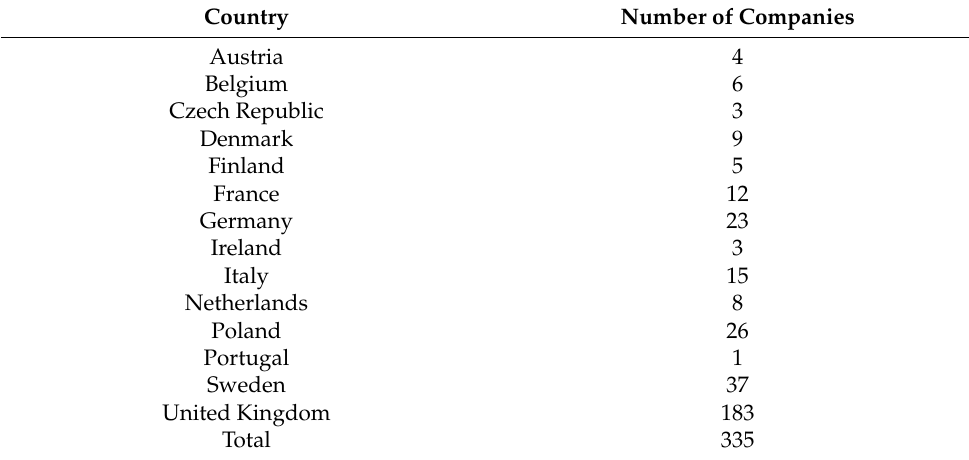
Table 1. Firms included in the sample per country. Source: Authors’ own elaboration.